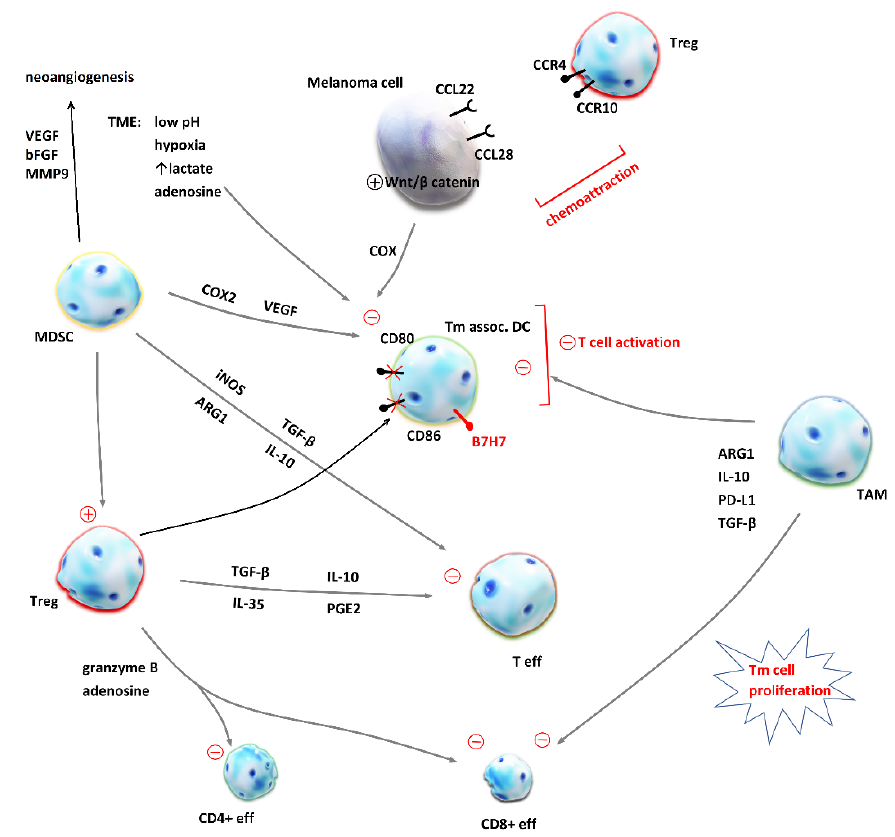
Figure 2. Mechanisms of immune suppression in the tumor microenvironment (TME). Malignant cells evade host’s antitumor response by the chemoattraction of immunosuppressive cells into the TME and the creation of a milieu which inhibits effector T cells (T eff ). Regulatory T cells (T reg ) release transforming growth factor β (TGF- β ), interleukin-10 (IL-10), interleukin-35 (IL-35) and prostanglandin E2 (PGE2), which inhibit T eff proliferation and cytokine release. In addition, T reg secrete granzyme B and adenosine [87] and lead to apoptosis of effector CD4+ and CD8+ T cells [88]. Cytotoxic CD8+ T cells are also inhibited by the tumor-associated macrophages (TAM) as they produce arginase 1 (ARG1) [89], IL-10, programmed death-ligand 1 (PD-L1) and TGF- β [90]. Dendritic cells (DC) are crucial for T cell priming and their inhibition by TAM, myeloid-derived suppressor cells (MDSC), melanoma cells and unfavorable conditions in the TME contribute to immunosuppression and resistance to immune checkpoint inhibition. MDSC produce inducible nitric oxide synthase (iNOS), TGF- β , ARG1 and IL-10, which inhibit effector T cells. On the other hand, MDSC inhibitory effect on DC is mediated by cyclooxygenase 2 (COX2) and vascular endothelial growth factor (VEGF) [91,92]. MDSC are also crucial for neoangiogenesis and tumor invasiveness, because they secrete VEGF, matrix metalloproteinase 9 (MMP9) and basic fibroblast growth factors (bFBF) [93]. Under the influence of T reg , DC express co-inhibitory membrane protein B7H7 and CD80 and CD86 are downregulated [90]. This impairs T cell activation. Chemoattraction of T reg is achieved by the expression of CCL22 and CCL28 on melanoma cell, ligands for CCR4 and CCR10 expressed on T reg [90]. The activation of an intrinsic Wnt/ β -catenin pathway in melanoma cell has been linked to deprived T cell infiltration of TME